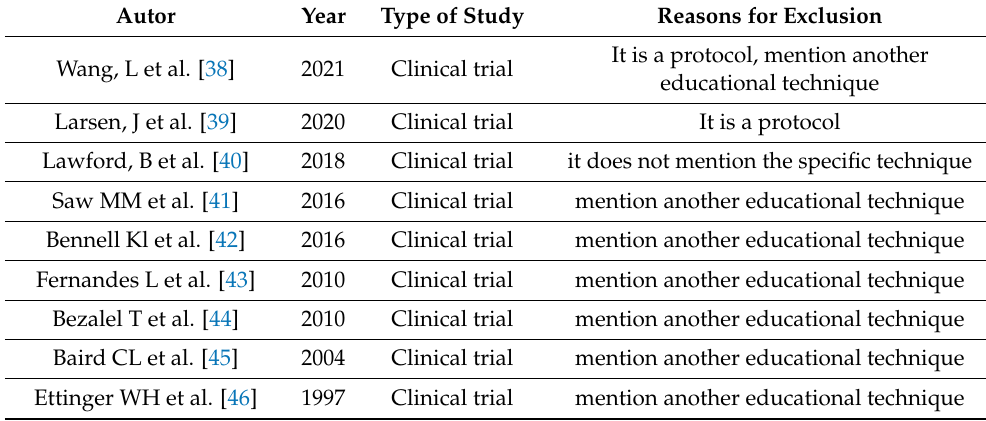
Table 3. Excluded